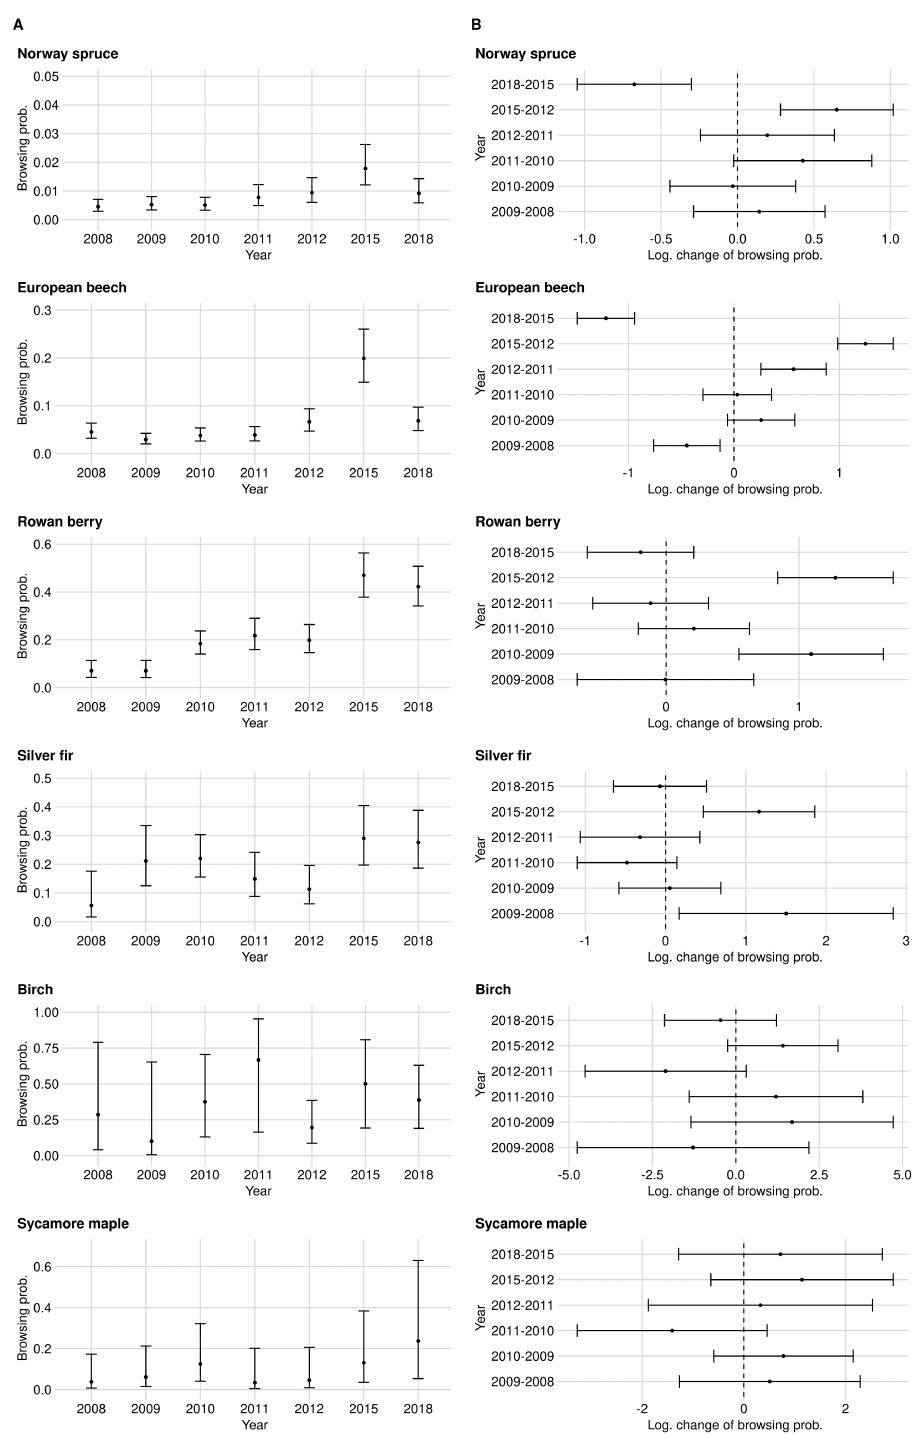
Figure A5. Time series and confidence intervals of the BP ( A ) and the corresponding logarithmic change of the BP between two consecutive acquisition years ( B ). The estimated logarithmic change of BP (black point inside the confidence intervals) is positive if BP increased compared to the previous year, and is negative if it decreased. If either the upper or the lower end of the confidence intervals completely crossed the zero on the x-axis, the change of the BP is not significant. The estimates are related to the FRG data